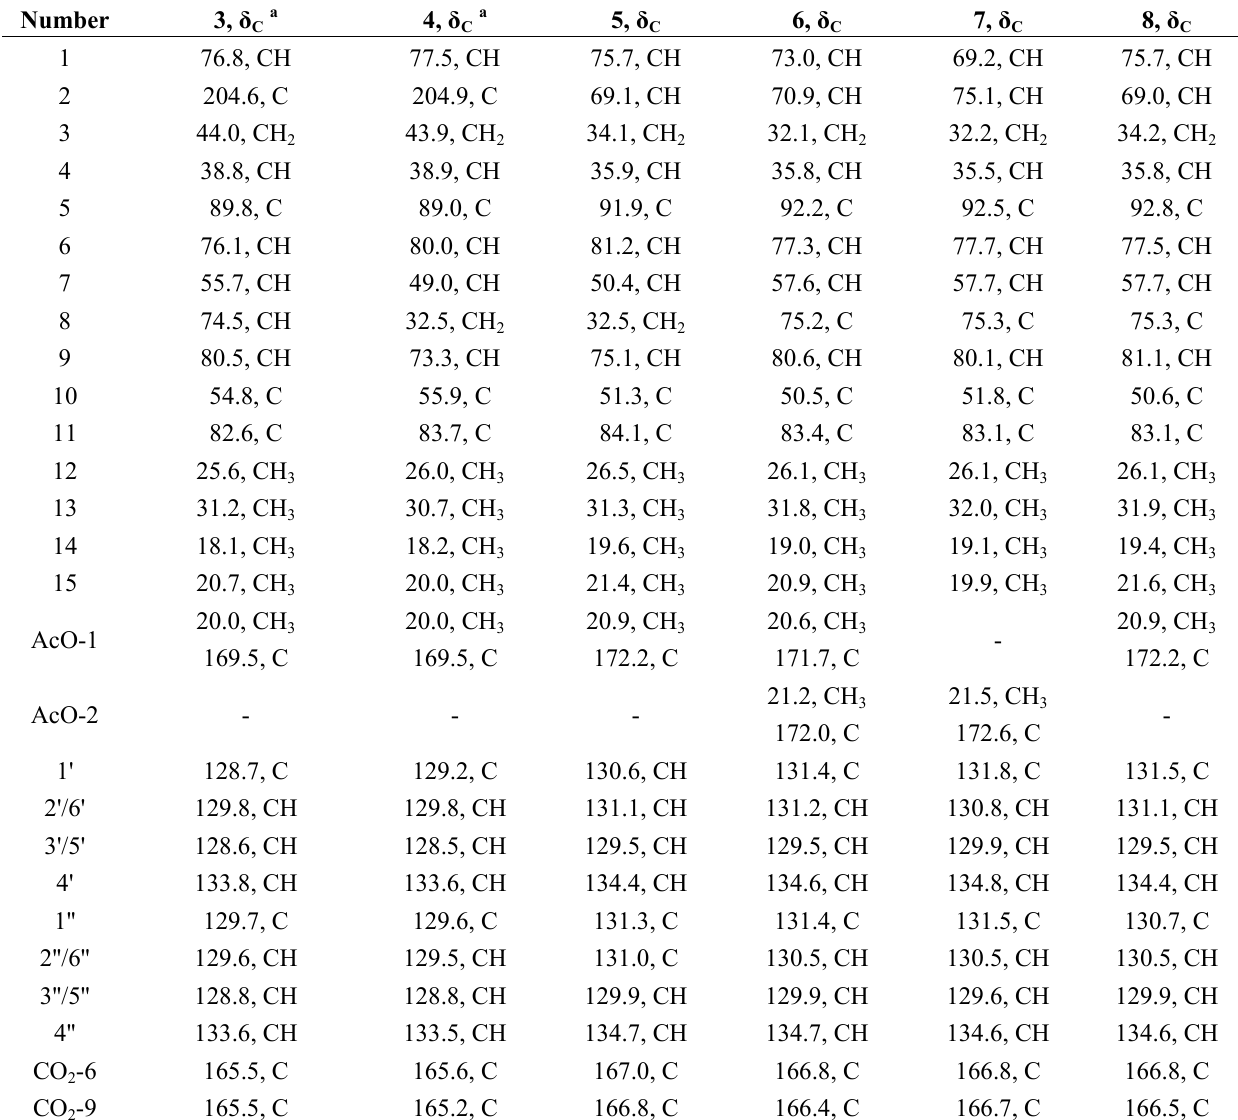
Table 1. 13 C NMR and DEPT data of compounds 3 – 8 (100